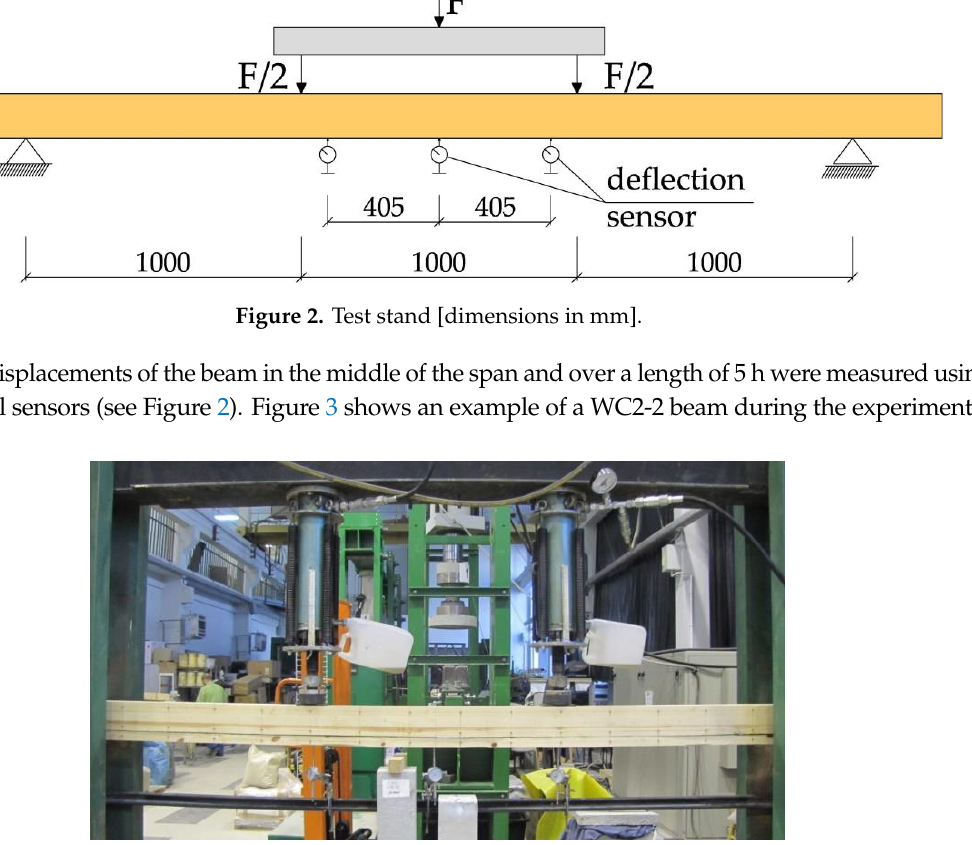
Figure 3. View of an exemplary model of WC2-2, reinforced along its entire length with CFRP fabric.